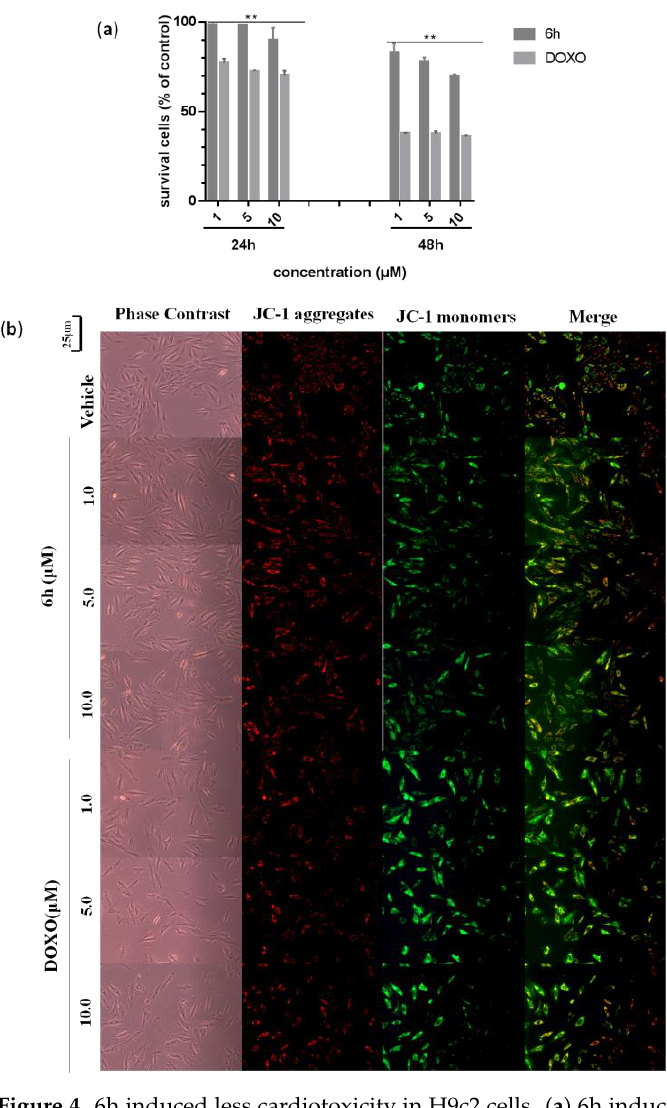
Figure 4. 6h induced less cardiotoxicity in H9c2 cells. ( a ) 6h induced less cardiac cell cytotoxicity. H9c2 cells were treated with 6h or DOXO for 24 h or 48 h, and cell viability was detected by CCK-8 method. Means ± SEM; n = 3; **: p < 0.01, 6h vs. DOXO. ( b ) 6h did not induce mitochondrial damage in H9c2 cells. H9c2 cells were maintained in media with or without 6h or DOXO for 24 h. Cells were stained with JC-1 and examined under a fluorescence microscope.